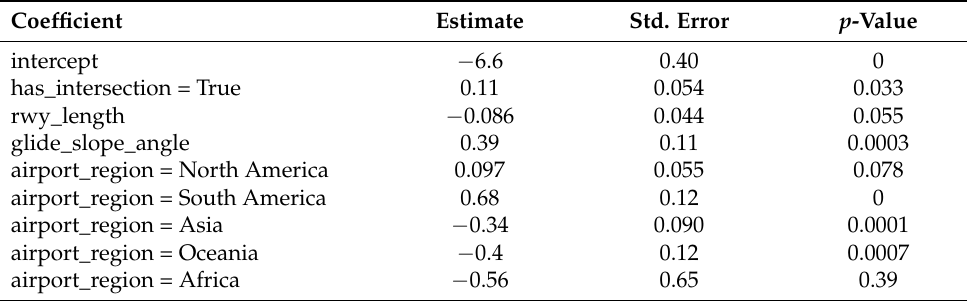
Table 4. Estimated model coefficients obtained from the quasi-binomial